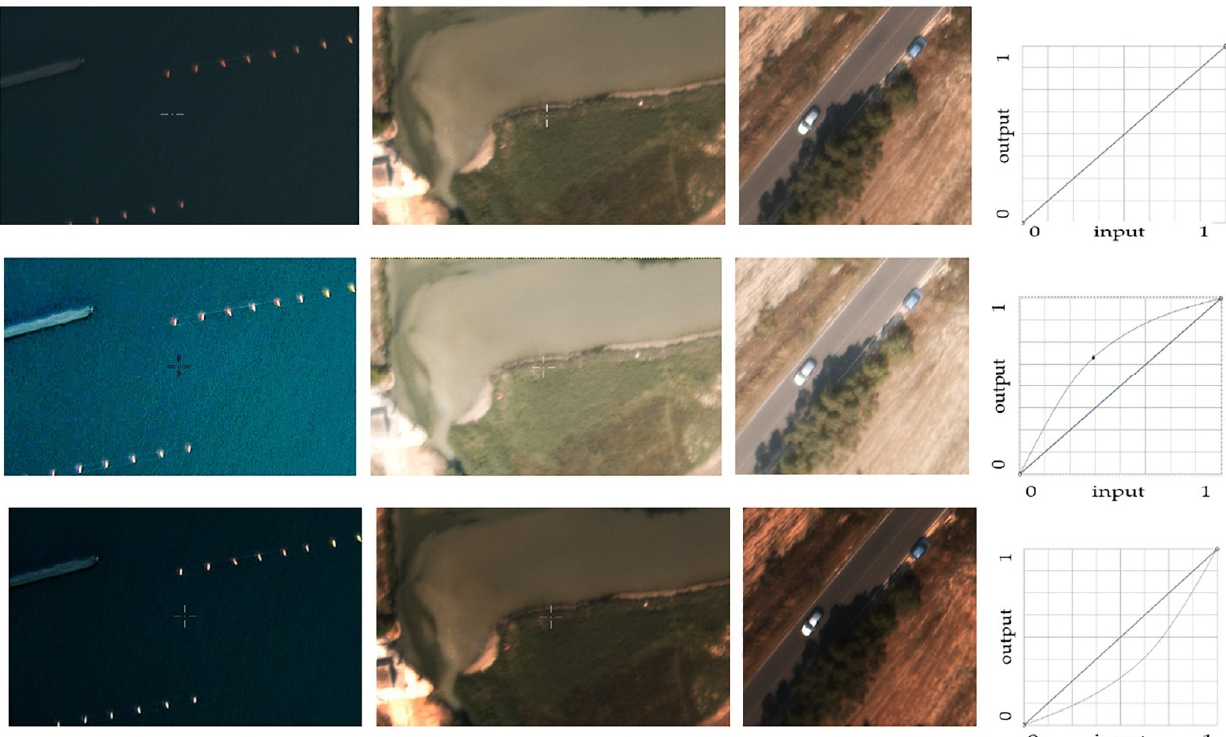
Figure 7. The figure represents how to change three of the ten keyframes used to empirically testing how to change three of the ten keyframes used to set empirically the gamma value based on acquired video files. On the right, the slope of the curve representing the relationship (in logarithmic terms) between signal and response.